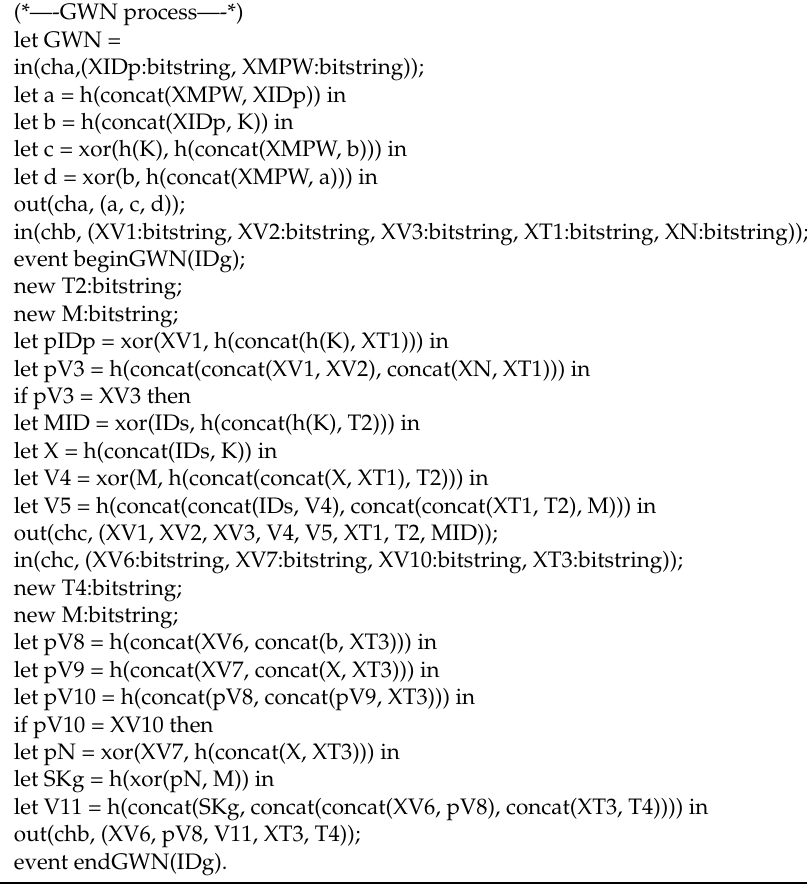
Table A3. Gateway Node Scheme.